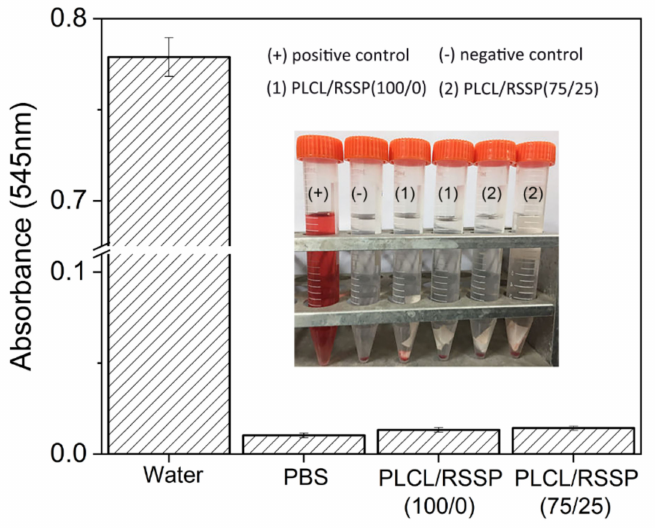
Figure 5. Hemolysis assays of PLCL/RSSP membranes in contact with blood in vitro ( n = 3). Picture inset shows the hemolytic condition after centrifugation.